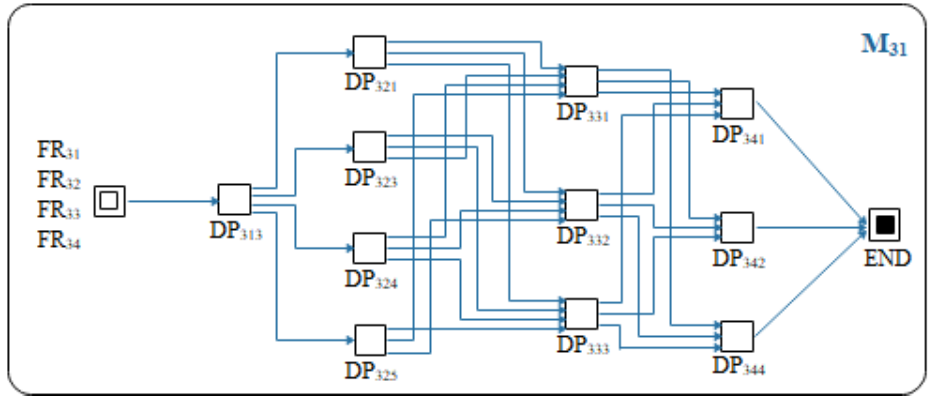
Figure 13. Schematic generation process diagram of FR 3 s. Table 9. List of FR 31 , FR 32 , FR 33 , FR 34.